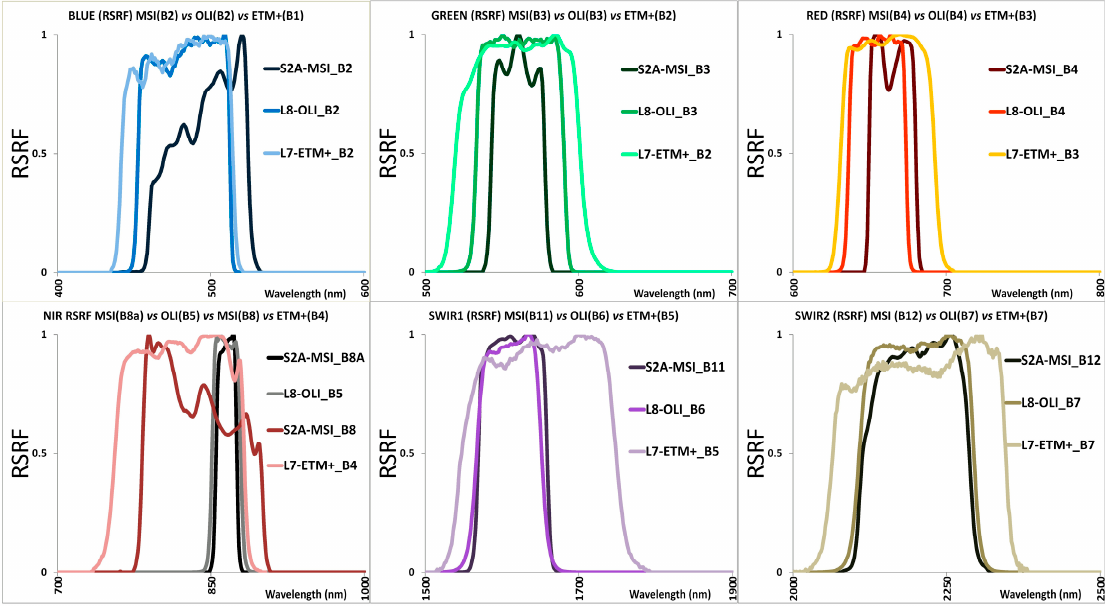
Figure 5. Relative Spectral Response Function (RSRF) of blue, green, red, NIR, SWIR1, and SWIR2 matching bands on MSI instrument in Sentinel-2A, OLI instrument in Landsat-8 and ETM+ instrument in Landsat-7 .